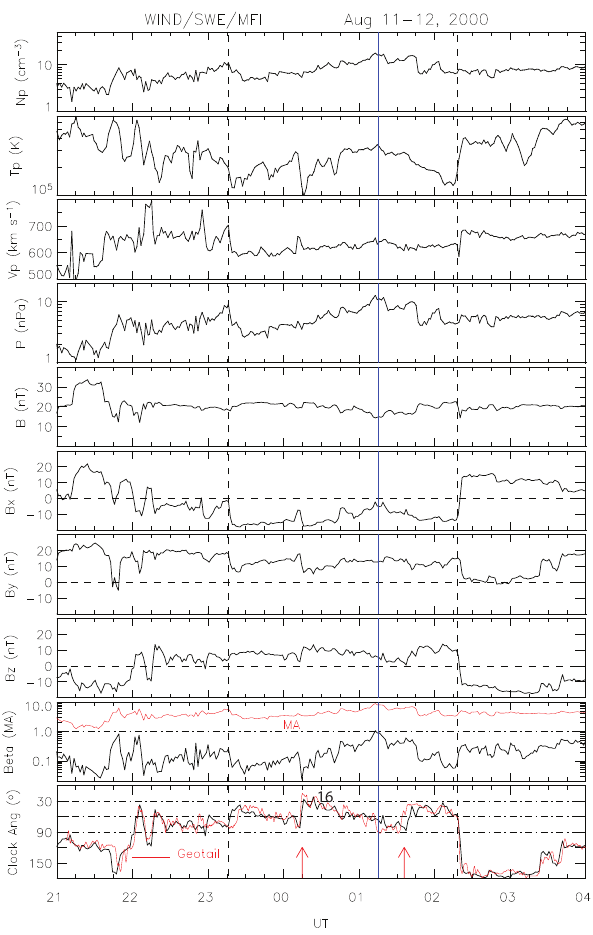
Fig. 4. Plasma and magnetic field data from spacecraft WIND for the interval 11 August, 21:00UT, to 12 August 2000, 04:00UT. Panels from top to bottom shows: proton density, temperature, bulk speed, dynamic pressure, total field, GSM components of the mag- netic field, proton plasma β and Alfv´en Mach number (red); and the clock angle, θ (polar angle in GSM Y-Z plane).